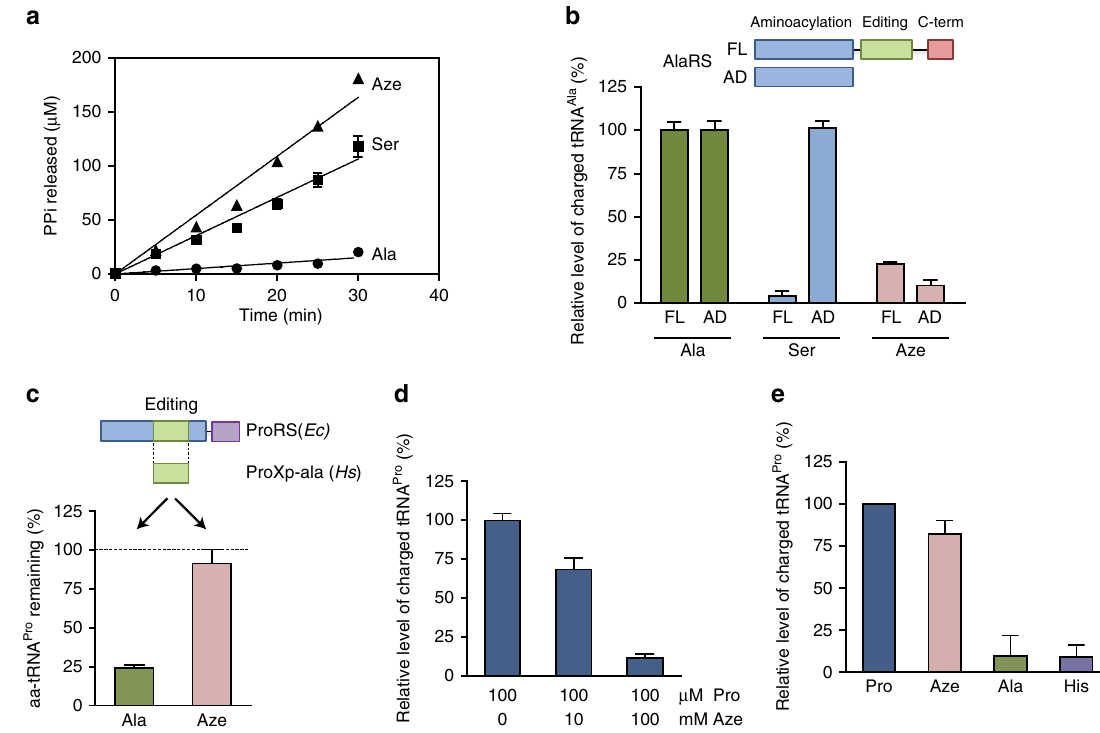
Fig. 5 Hs AlaRS has pre-transfer editing activity against Aze, Hs ProRS has no editing activity against Aze. a ATP hydrolysis in the presence of 20 mM Ala, 100 mM Ser, or 100 mM Aze with 1 µ M Hs AlaRS. b Relative level of charged tRNA Ala after aminoacylation for 5 min by full-length Hs AlaRS (FL) or aminoacylation domain of AlaRS (AD) with either 2.5 mM Ala, Ser, or Aze. c Deacylation assay with Hs ProXp-ala using either Ala-tRNA Pro or Aze- tRNA Pro . d Aminoacylation of tRNA Pro by Hs ProRS with Pro in the presence of different concentrations of Aze at 20 min. e Relative level of charged tRNA Pro after 20 min aminoacylation by Hs ProRS with either 2.5 mM Pro, Aze, Ala, or His. (All graphs represent mean ± s.d., average of three experiments.)